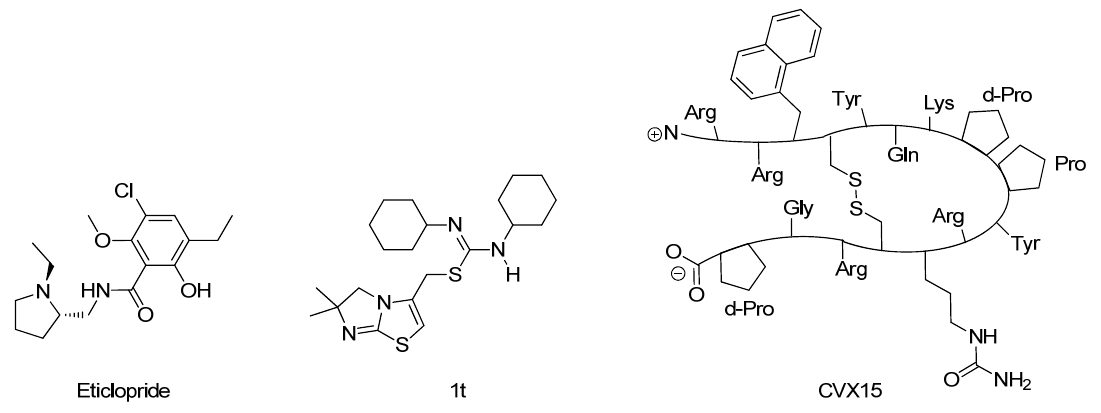
Figure 1. Chemical structures of eticlopride, 1t and CVX15. The first is co-crystallized with the dopamine D3 Receptor and the latter two with the chemokine Receptor